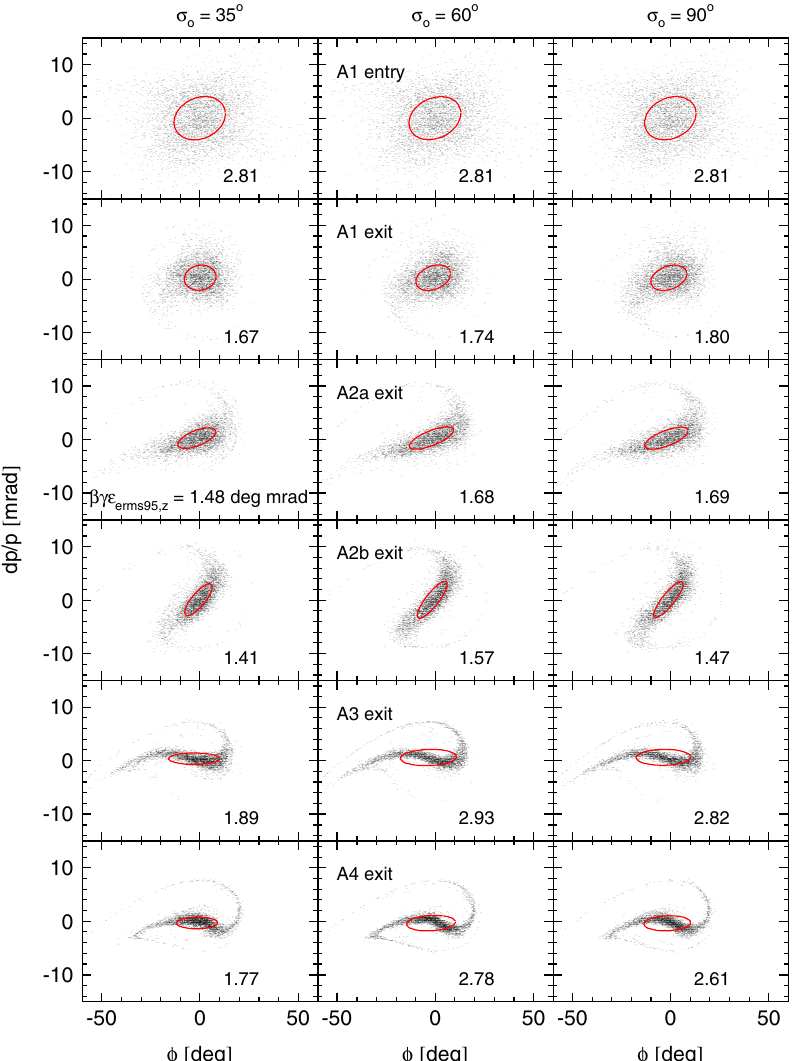
FIG. 13. (Color) DYNAMION -simulated longitudinal phase space distributions at the end of the tanks of the DTL for transverse zero current phase advances (cid:4) o of 35 (cid:1) (left), 60 (cid:1) (center), and 90 (cid:1) (right). The specific tank and the corresponding normalized longitudinal 95% rms emittance are indicated. The emittance refers to 108 MHz and to the relative momentum